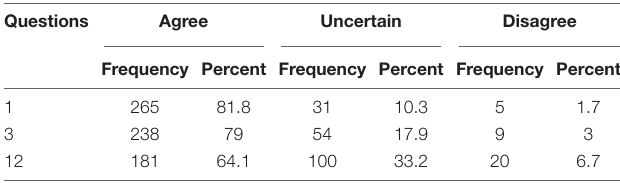
TABLE 8 | Frequency and percent of the questions related to the learners’ autonomy in technology integration learning environments.